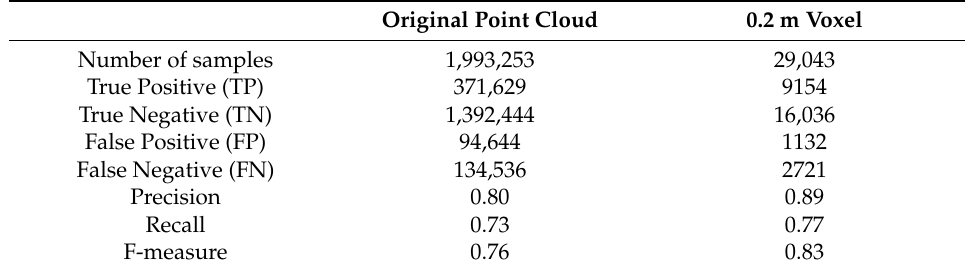
Table 1. Accuracy assessment of GSR estimation.